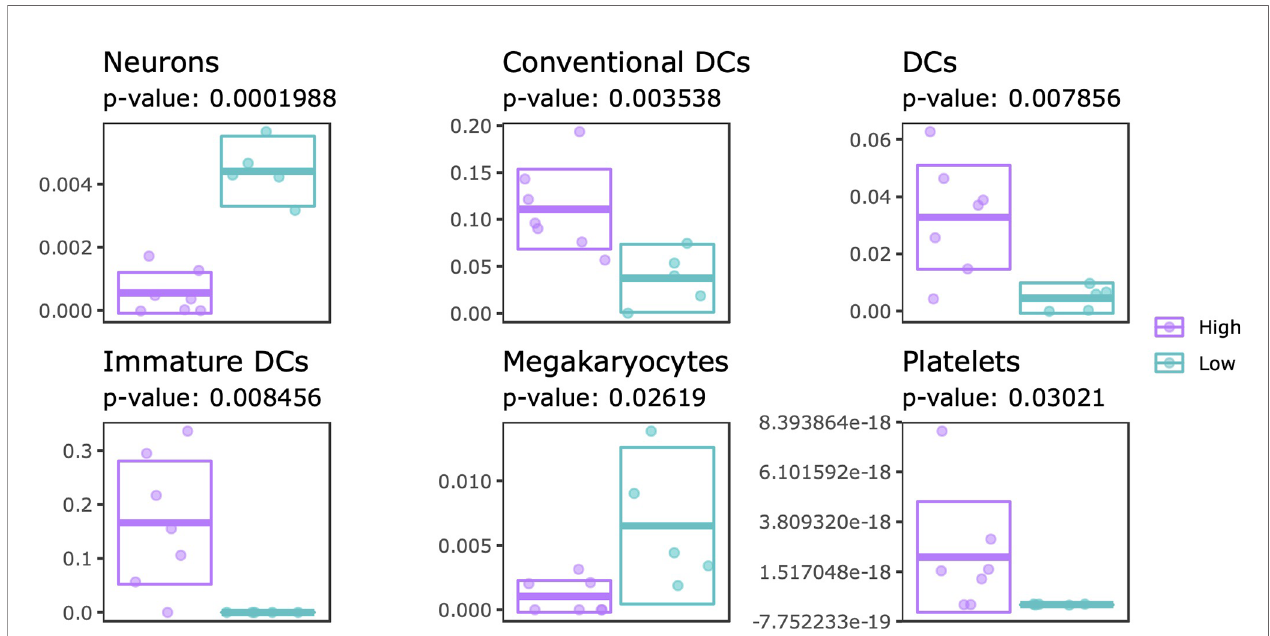
FIGURE 6 | Cellular composition estimation. Cellular proportions were estimated for 64 cell types using the xCell algorithm. Of these, 6 cell types were found to be signi fi cantly different when comparing SJC66 high with SJC66 low . Visualized as scatter- and cross-bar plots are the signi fi cantly differentially represented cell types, namely the neurons, conventional dendritic cells (cDC), dendritic cells (DC), immature dendritic cells (iDC), megakaryocytes, and